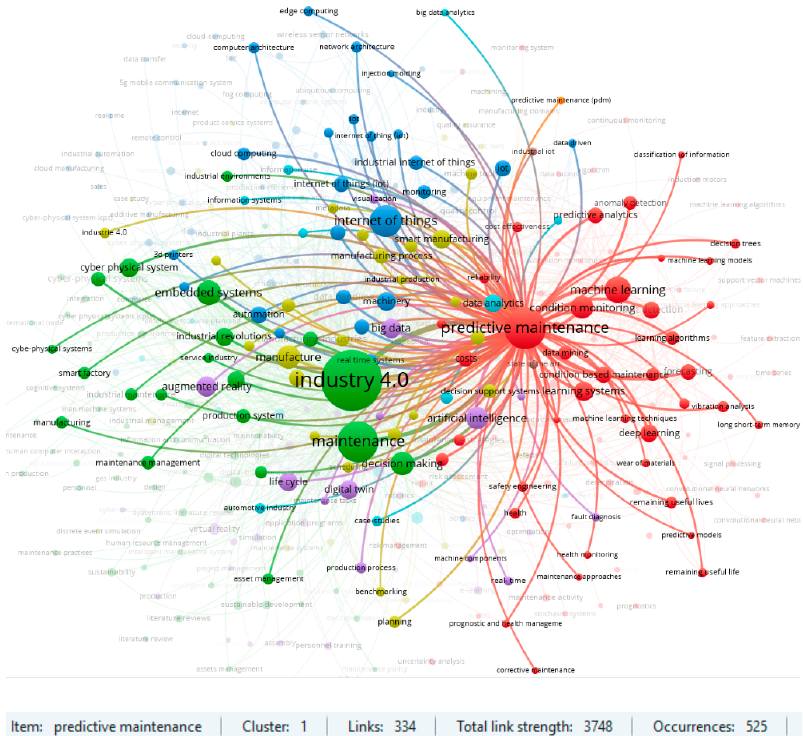
Figure 17. Analysis of keyword strength for the first cluster of publications from the Scopus database. Source: own development using VOSviewer software [101].